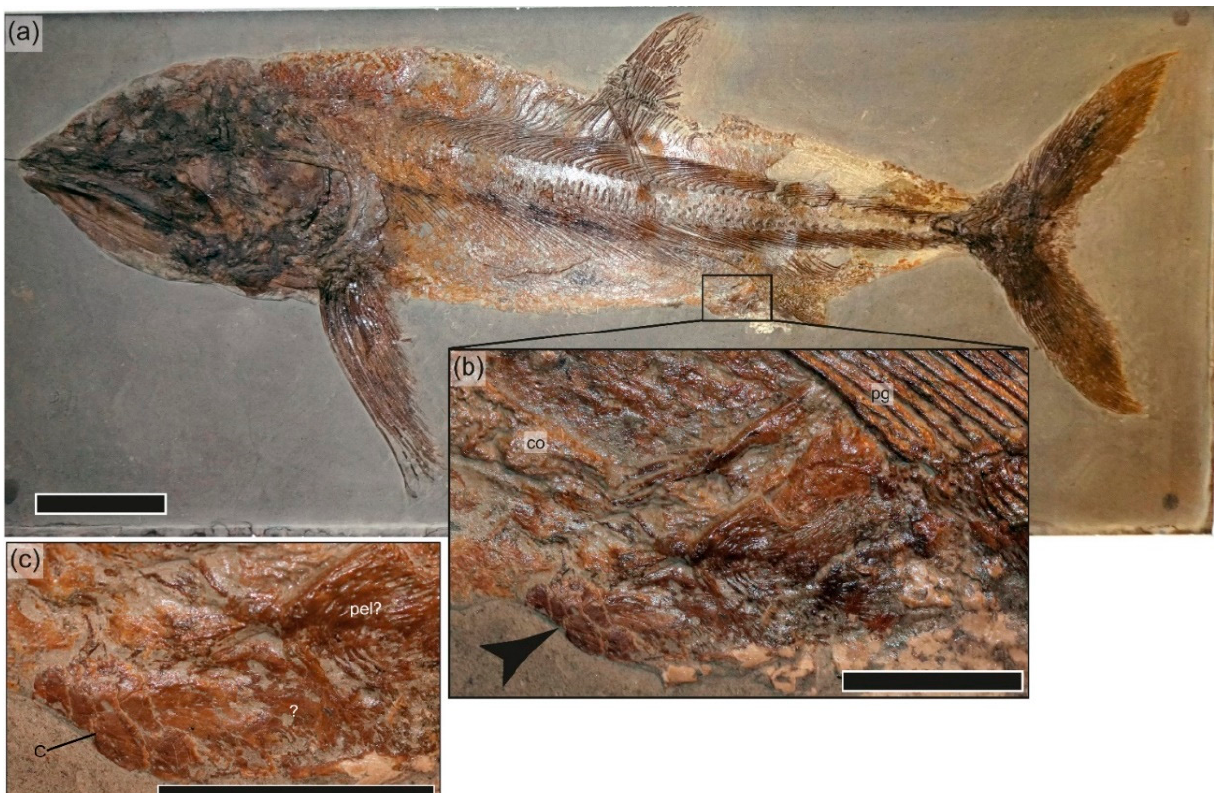
Figure 9 . GPIT-PV-31586, Pachycormus macropterus . ( a ) Overview photo; ( b ) inset showing the crustacean remains anterior to the anal fin, indicated by arrow. ( c ) Close-up of ( b ). Abbreviations: c, crustacean; co, cololite; pel? pelvic plate; pg, anal pterygiophores. Scale bars = 10 cm ( a ); 20 mm ( b , c ).